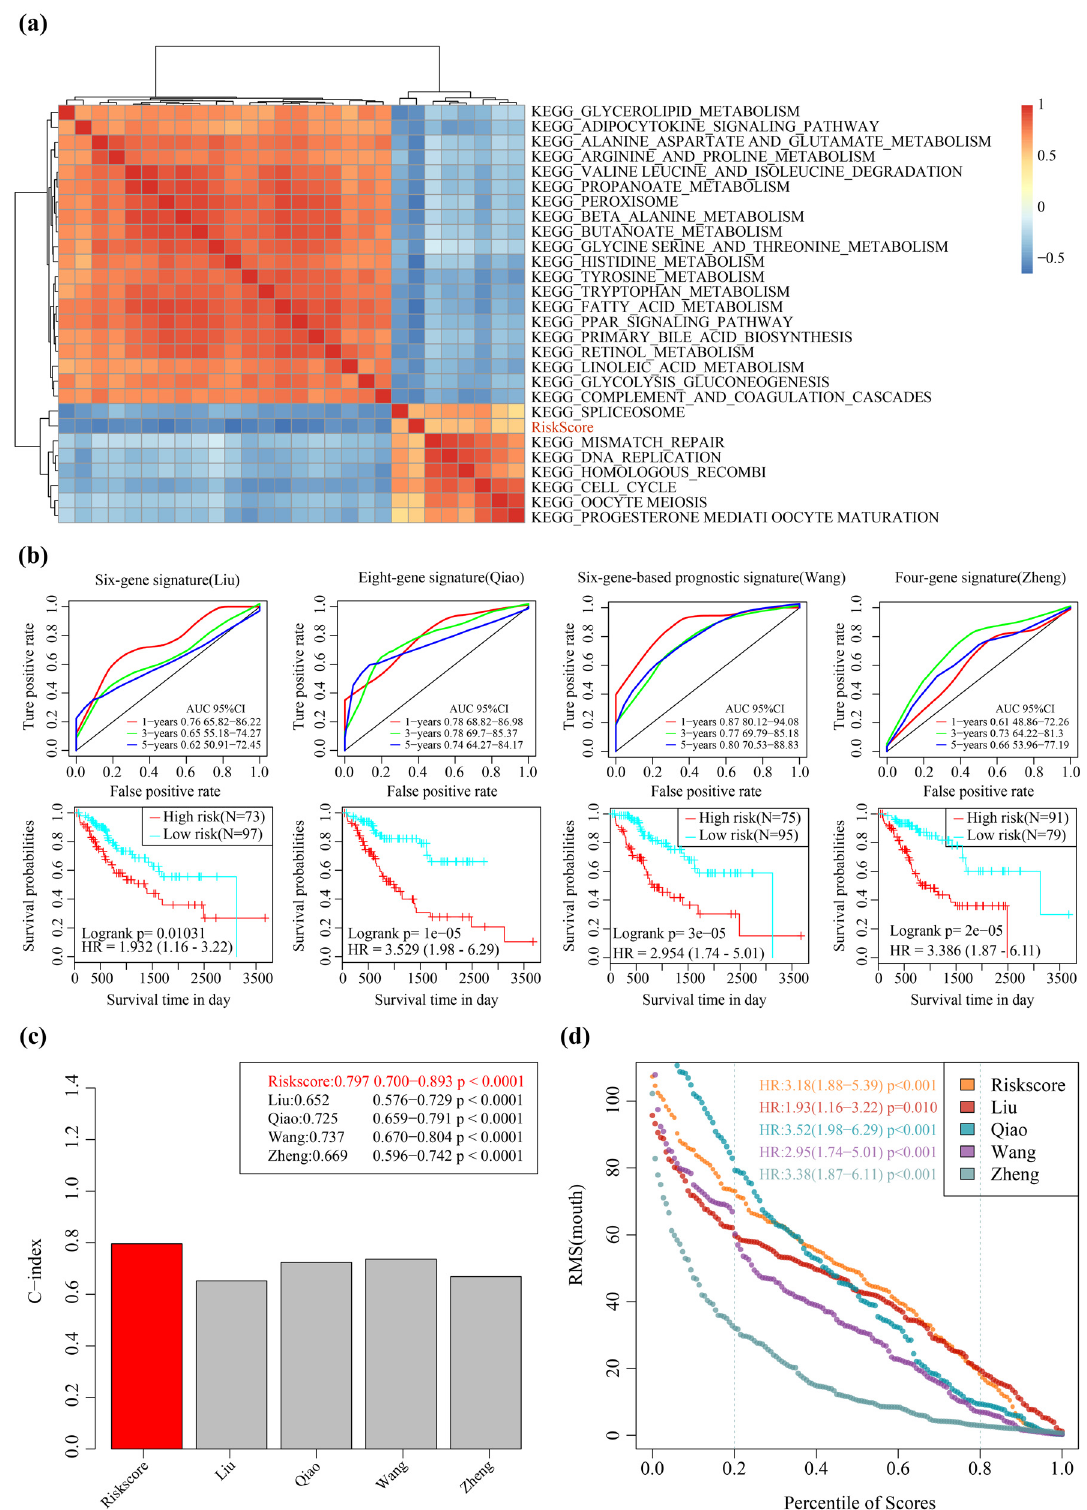
Figure 7: Comparing the 4 - mRNA signature with the existing model and the potential - related regulatory pathway: ( a ) clustering of corre - lation coe ffi cients between KEGG pathways with RiskScore greater than 0.5 and RiskScore, ( b ) AUC curve and prognosis KM curve of four models in the TCGA training set, ( c ) C - index of fi ve prognostic risk models, and ( d ) restricted mean survival ( RMS ) curve of fi ve prognostic risk models. The dashed line represents RMS time ( months ) corresponding to 20 and 80% percentile score,